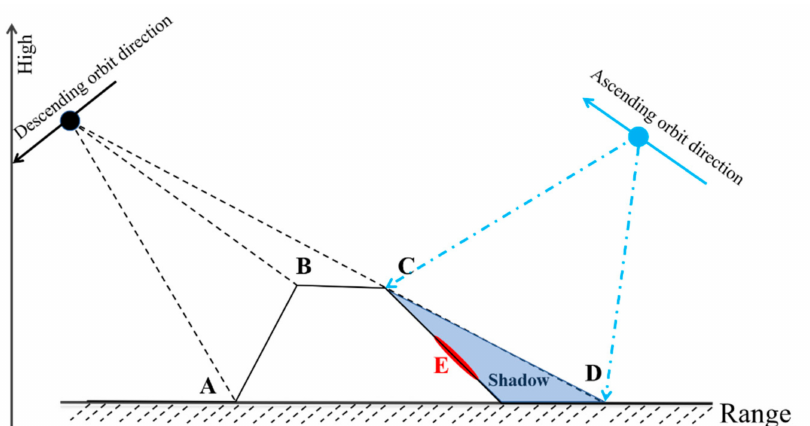
Figure 12. Schematic diagram of potential landslide identification in the ascending and descending track data (Red zone represents the location of the landslide. In the descending track data, the AB area is the area with good identification effect, and CD is the shaded area; in the ascending track data, CD is the area with good identification effect. area, AB is the shaded